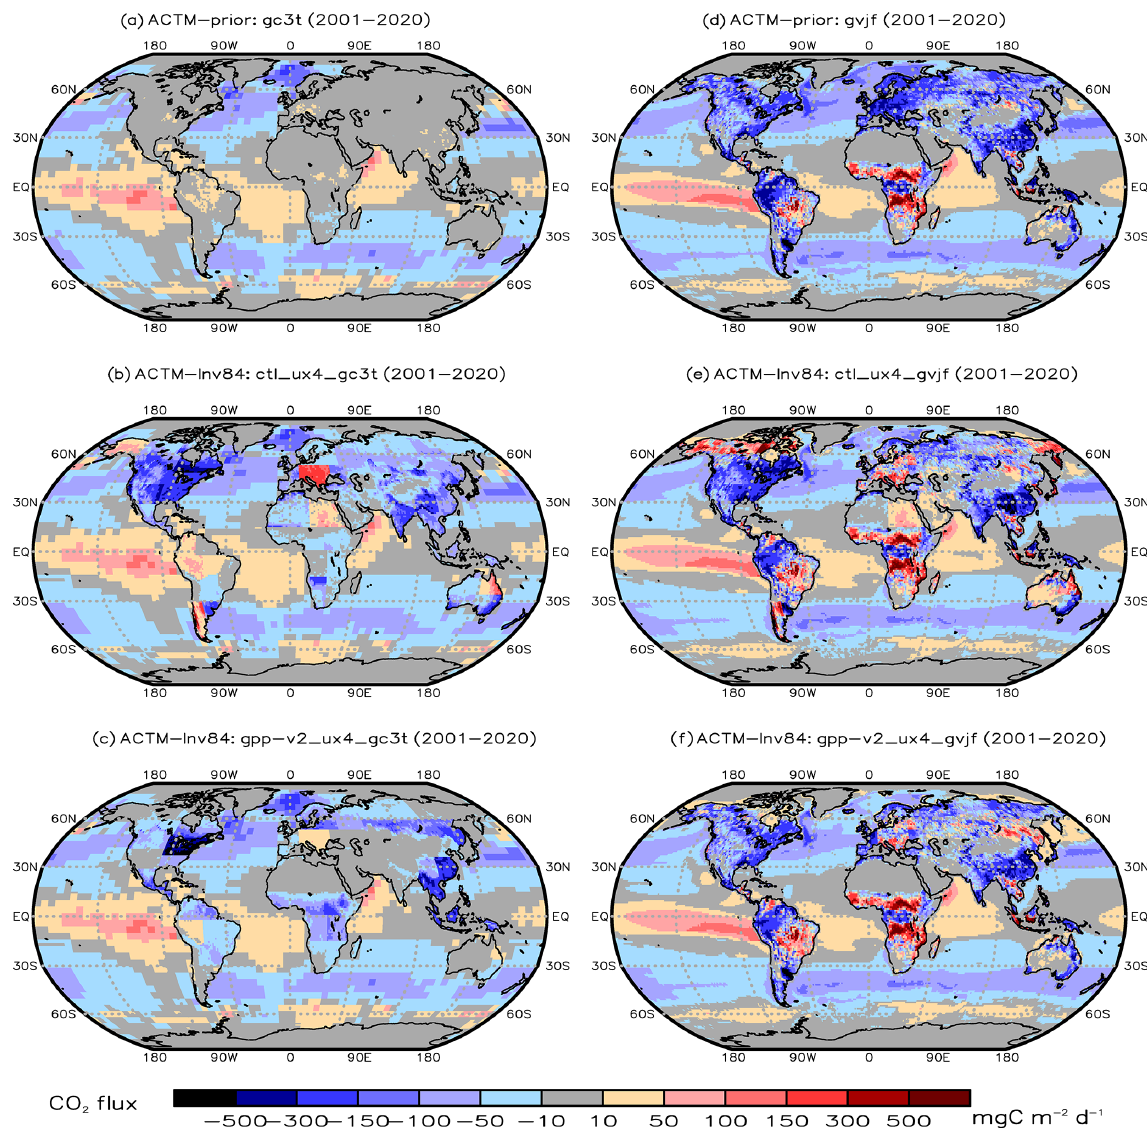
Figure 4. Spatial distributions of CO 2 prior flux for two different sets of land and ocean flux combinations (a, d) . The middle (b, e) and bottom (c, f) panels show predicted CO 2 fluxes using two different prior flux uncertainty patterns (ctl,